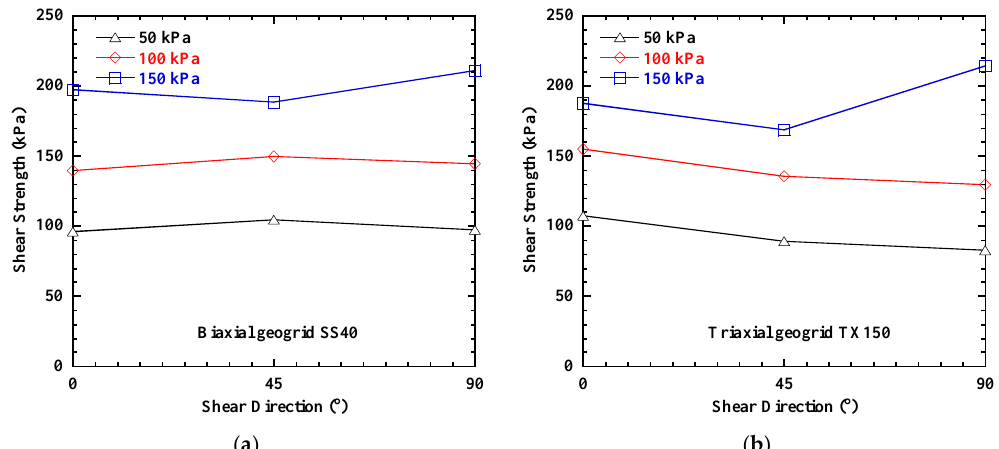
Figure 14. The influence of shear direction on the shear strength of gravel–biaxial geogrid (SS40) and gravel–triaxial geogrid (TX150) interfaces. ( a ) SS40, ( b ) TX150.